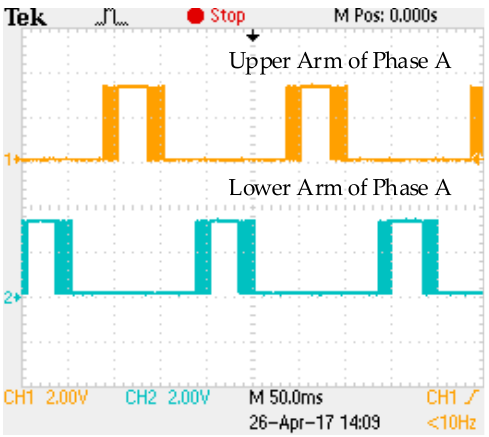
Figure 23. The waveform of PWM output.